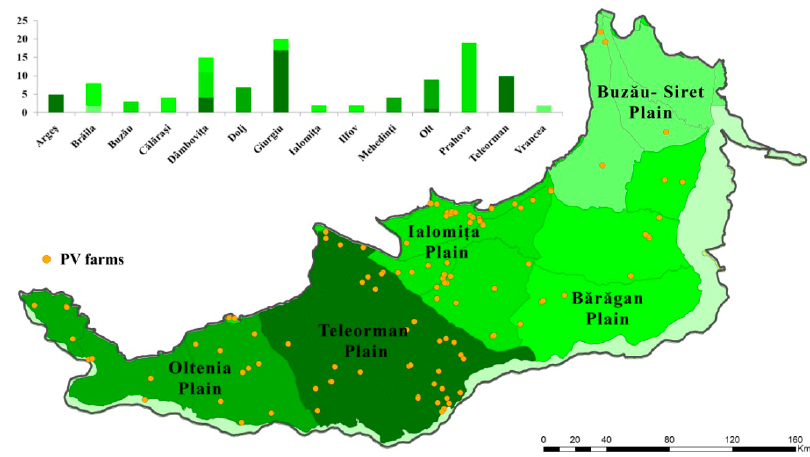
Figure 3. Spatial distribution of PV farms on relief units.